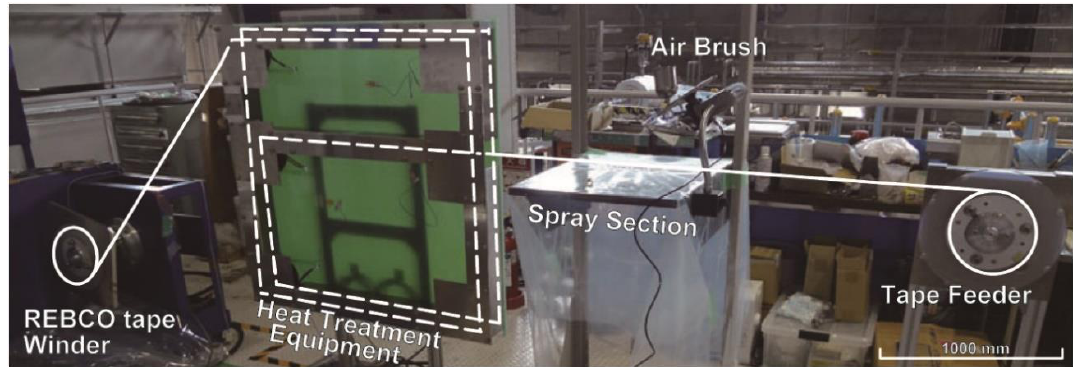
Figure 5. Reel-to-reel continuous coating system.